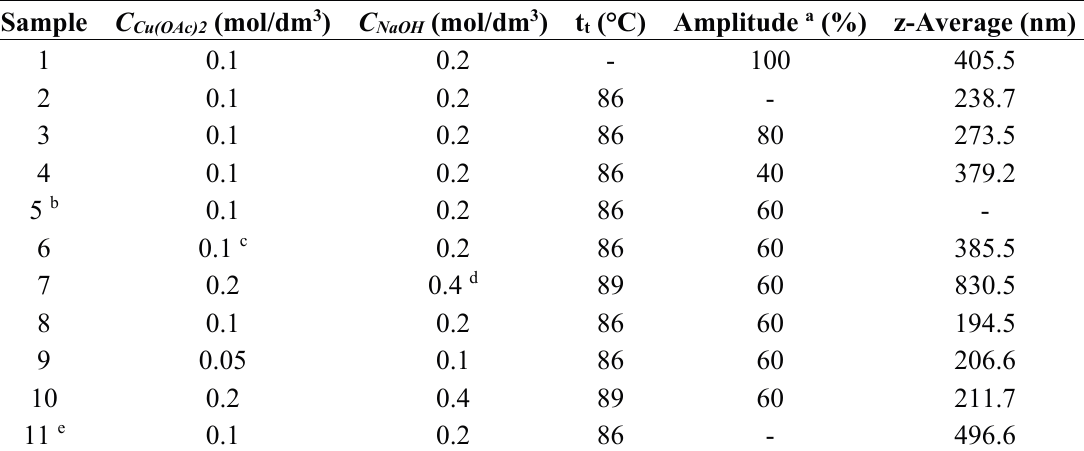
Table 1. Results of the CuO nanoparticles preparation